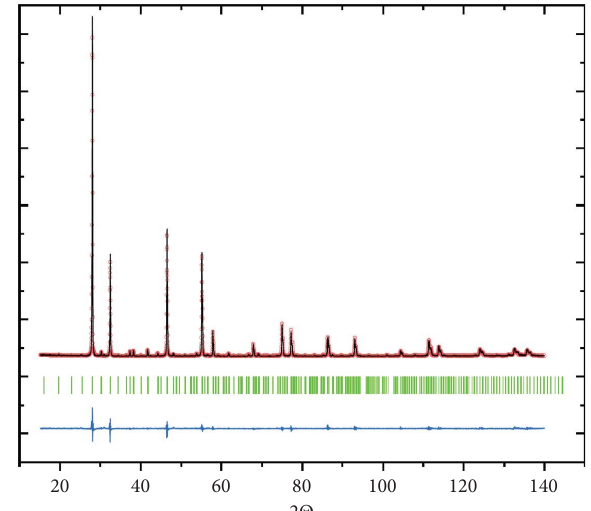
Figure 7: Experimental (red dots) and calculated (black profle) XRD patterns, their diference (blue profle), and Bragg refection positions (green lines) of the Nd 4.85 Tb 0.15 Mo 3 O 16+ δ solid Figure 6: Microstructure image of the Nd 4 Tb 1 Mo 3 O 16+ δ sample. Table 3: Chemical element content of the Nd 4 Tb 1 Mo 3 O 16+ δ sample, at %. Exp. (large Exp. (small particles, Element Calc Exp. (total) spectra 1, 2)